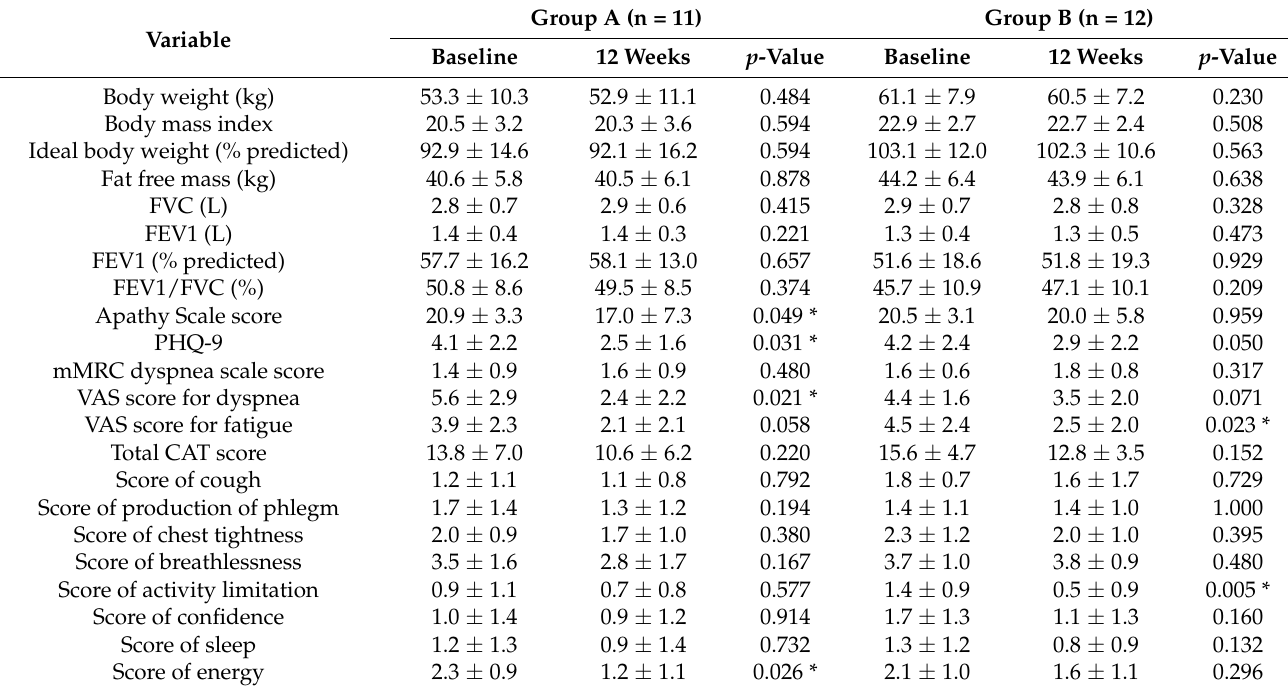
Table 2. Changes in body composition, clinical symptoms, and